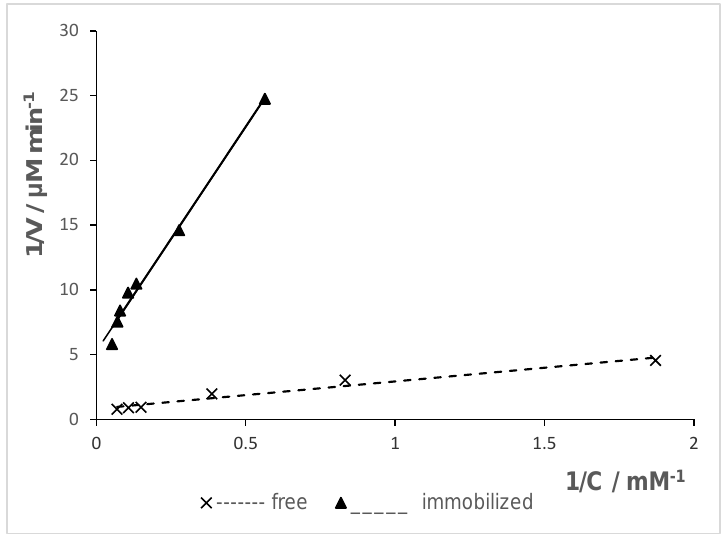
Figure 6. Lineweaver—Burk plots of free and immobilized naringinase. V—initial rate of naringin hydrolysis; C—naringin concentration.